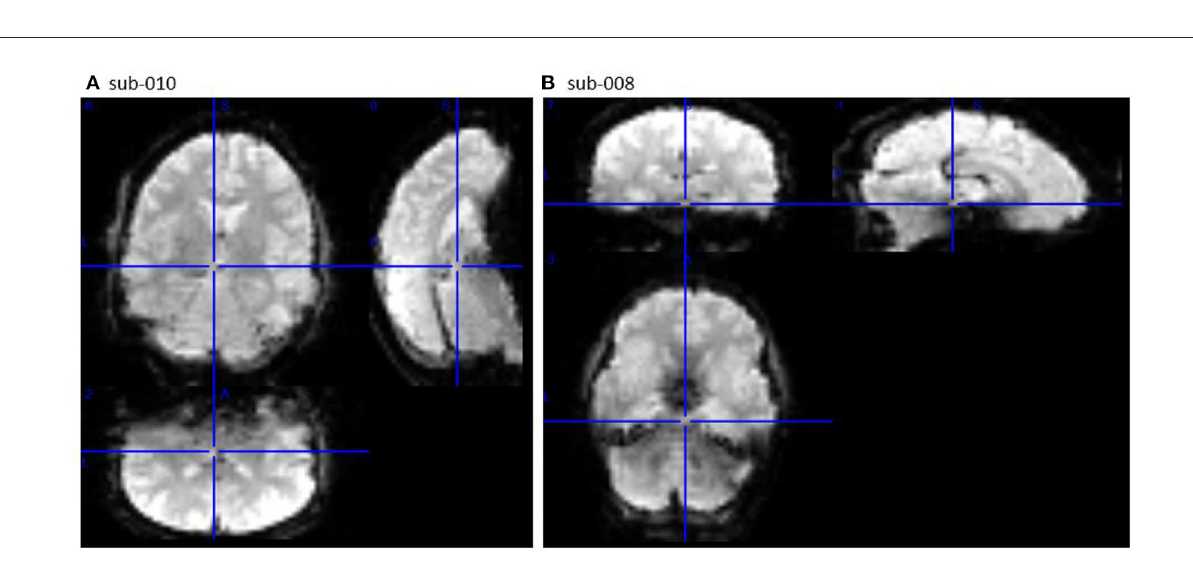
FIGURE2 Frame 100 of the raw image timeseries (_bold.nii.gz) for sub-010 [left, (A) ] and comparison sub-008 [right, (B) ], viewed in MRIcron (Rorden et al., 2007; RRID:SCR_002403). sub-010 was not acquired with the same parameters as sub-008 (and the other